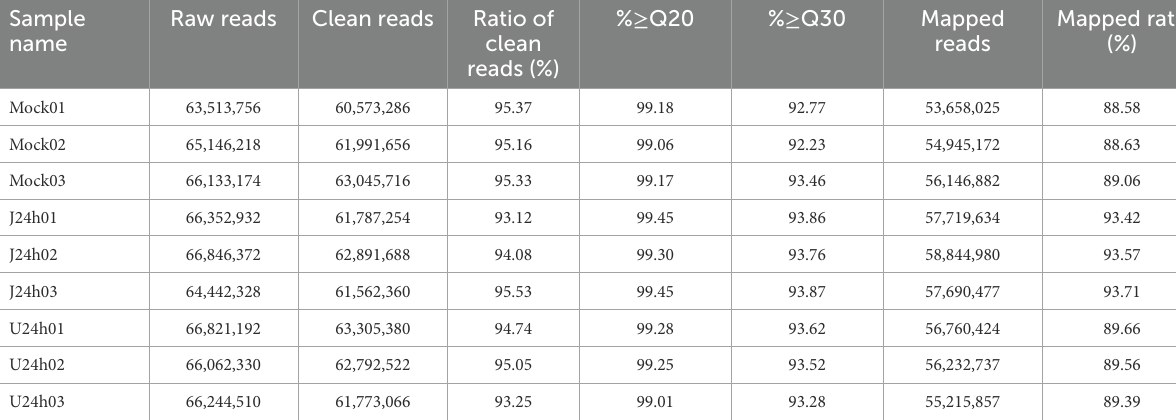
TABLE 1 Summary of the quality analysis of RNA-seq